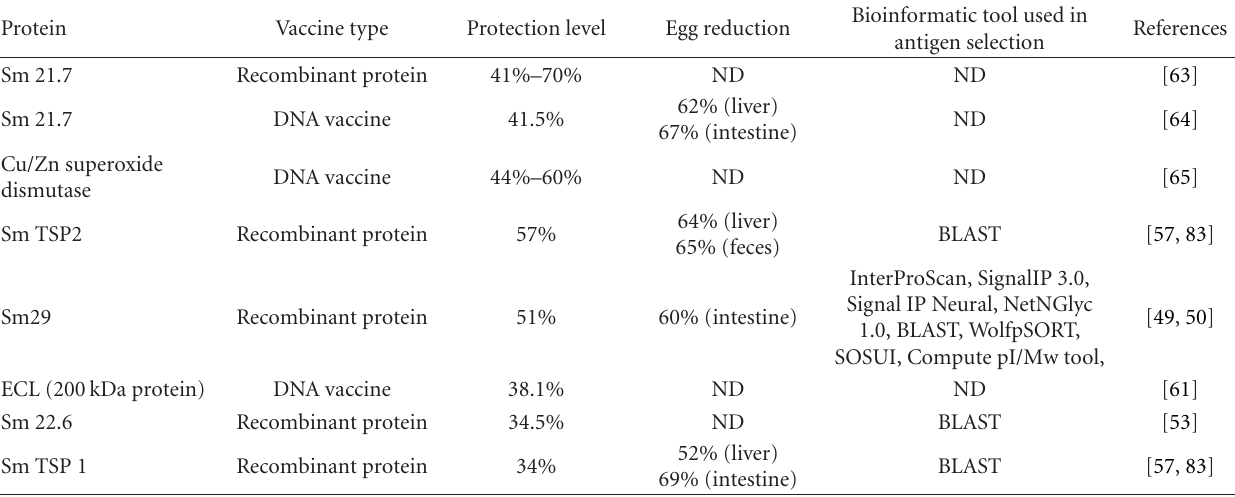
Table 1: Schistosome tegument protein evaluated as vaccine candidates in preclinical